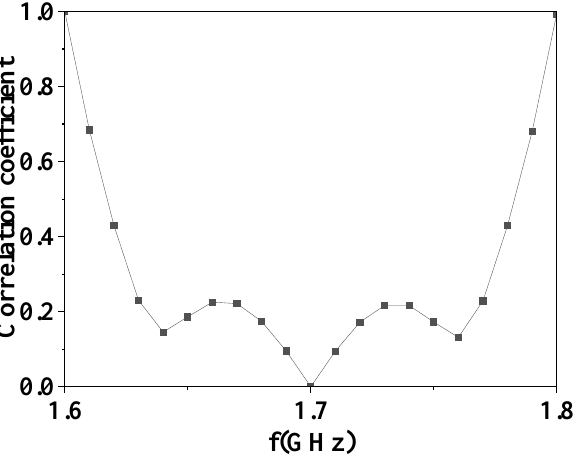
Figure 8. Correlation coefficient of the transmission matrix for double PIM sources. The imaging result of the center frequency is shown in Figure 9.